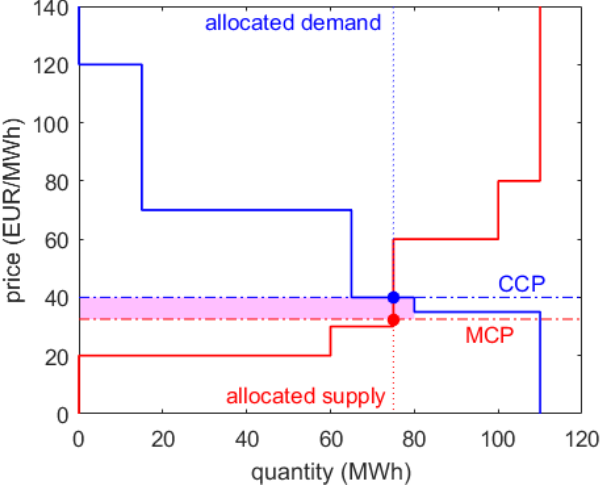
Figure 5. Illustration of the clearing example and its optimal results with reduced flexibility cost.